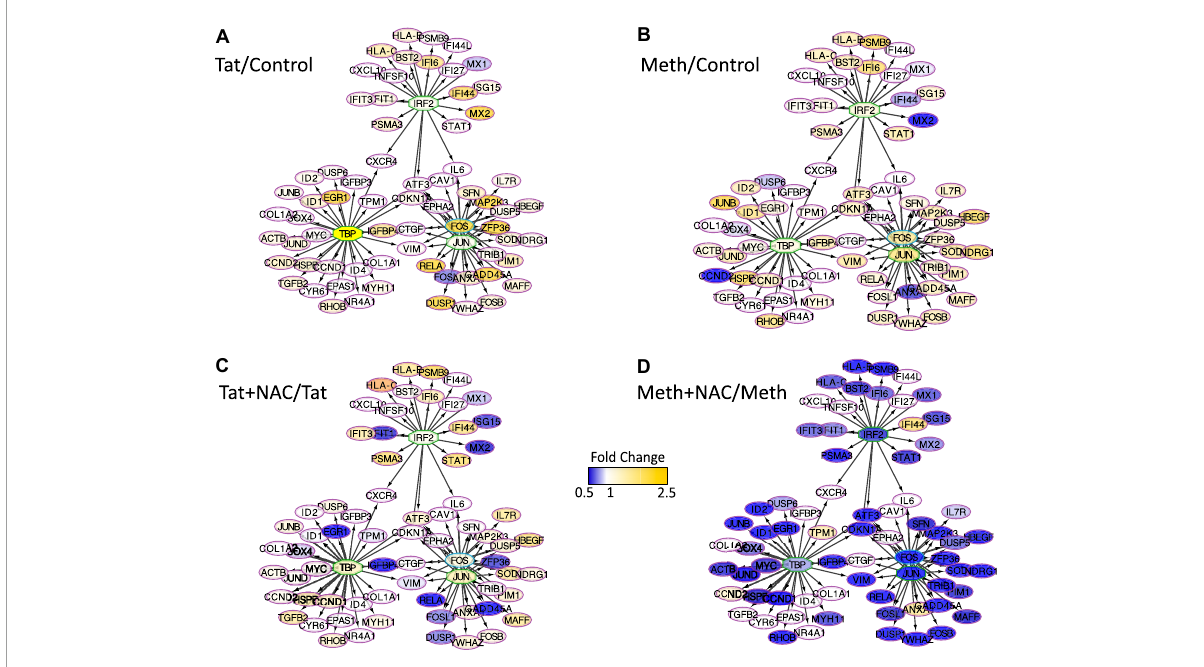
FIGURE8 Transcription factor predictions derived from changes in RNAPol caused by Tat, overlapping and interacting with the effects of ROS. Visualization of the RNAPol promoter recruitment changes in THP1 cells 15 min after stimulation with (A) HIV Tat (10 ng/ml) in relation to control, (B) Meth (60 uM) in relation to vehicle control, (C) Tat + NAC in relation to Tat, and (D) Meth + NAC in relation to Meth alone. TRANSFAC prediction was confirmed using merged iRegulon-predicted transcription factor megatargetomes, for visualization of significant ( p < 0.05) relative fold changes and cluster regulation. IRF2, TBP and cJUN/cFOS (AP1) positioned in the center of regulated gene clusters, and RNAPol recruitment to gene promoters is indicated by node colors, decreased in tones of blue and increased recruitment in tones of yellow.